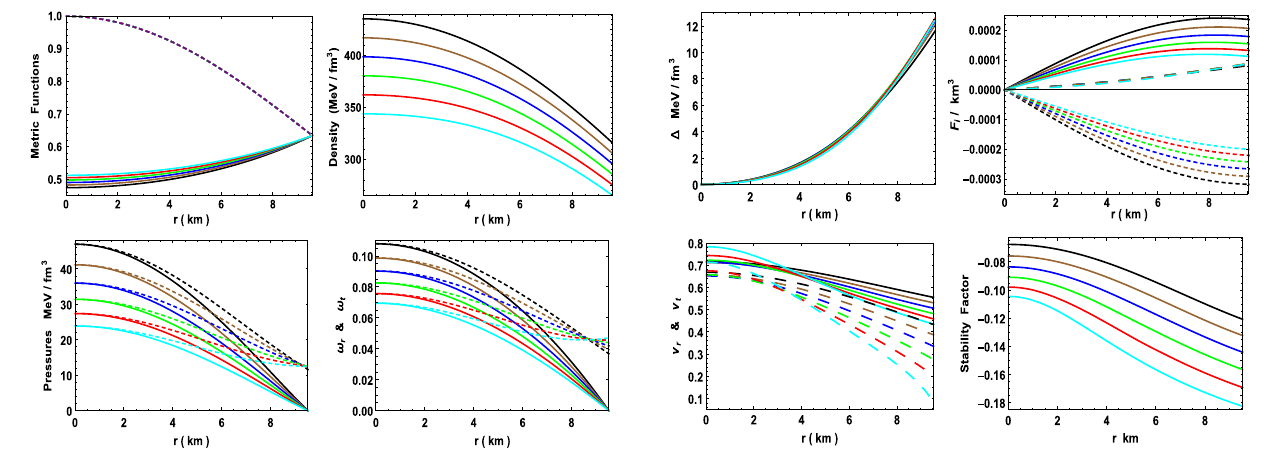
Fig. 19 Variation of metric functions ( e ν − solid, e − λ − dashed), den- sity, pressures ( p r − solid, p t − dashed) and equation of state parame- ters ( ω r − solid, ω t − dashed) with radial coordinate r for 4U 1608-52 ( M = 1 . 74 M (cid:9) , R = 9 . 528 km) by taking a = 0 . 001 km − 2 and n = 3. We are using the same color notation in all the graphs from Figs. 19, 20 and 21 as β = 0 (black), 0.014 (brown), 0.028 (blue), 0.042 (green), 0.056 (red) and 0.07 (cyan)